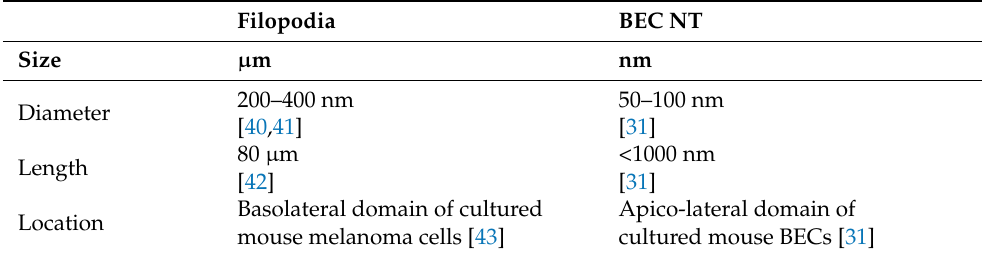
Table 1. Comparison between filopodial and BEC NTs.